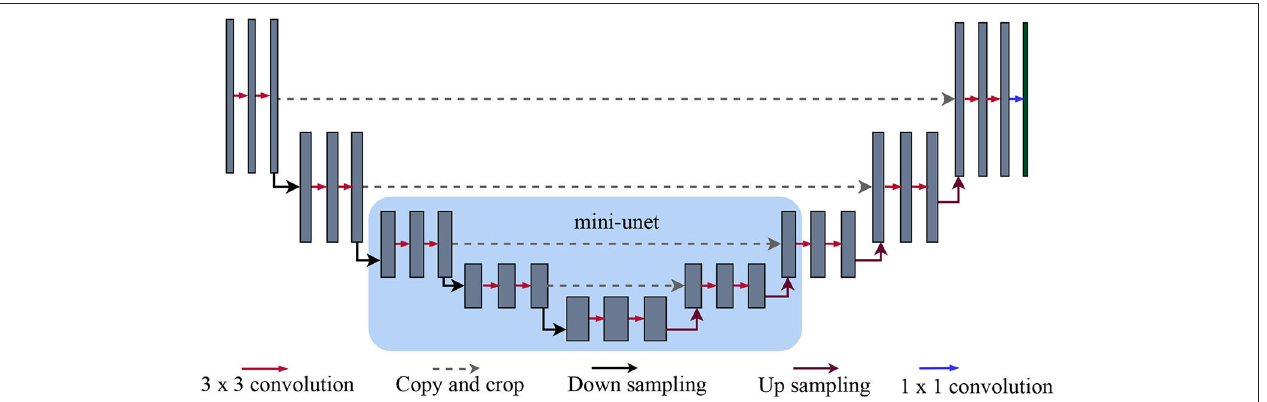
FIGURE 2 | U-net and mini-U-net architectures: As originally detailed in (Ronneberger et al., 2015), the first half of the U-net architecture is a standard sequence of convolution and max-pooling layers. The layers in the second half, on the other hand, receive two inputs: the features from the previous layer and the features from the corresponding layer in the first half of the network (i.e., the one with the same dimensionality). The features from previous layers are upsampled to match the larger dimensions of subsequent layers. Intuitively, the upsampled features provide more global information, while the features transferred from the earlier layer give more local information. Our mini-U-net architecture (highlighted by the light blue square) consists of the middle layers of the full U-net.